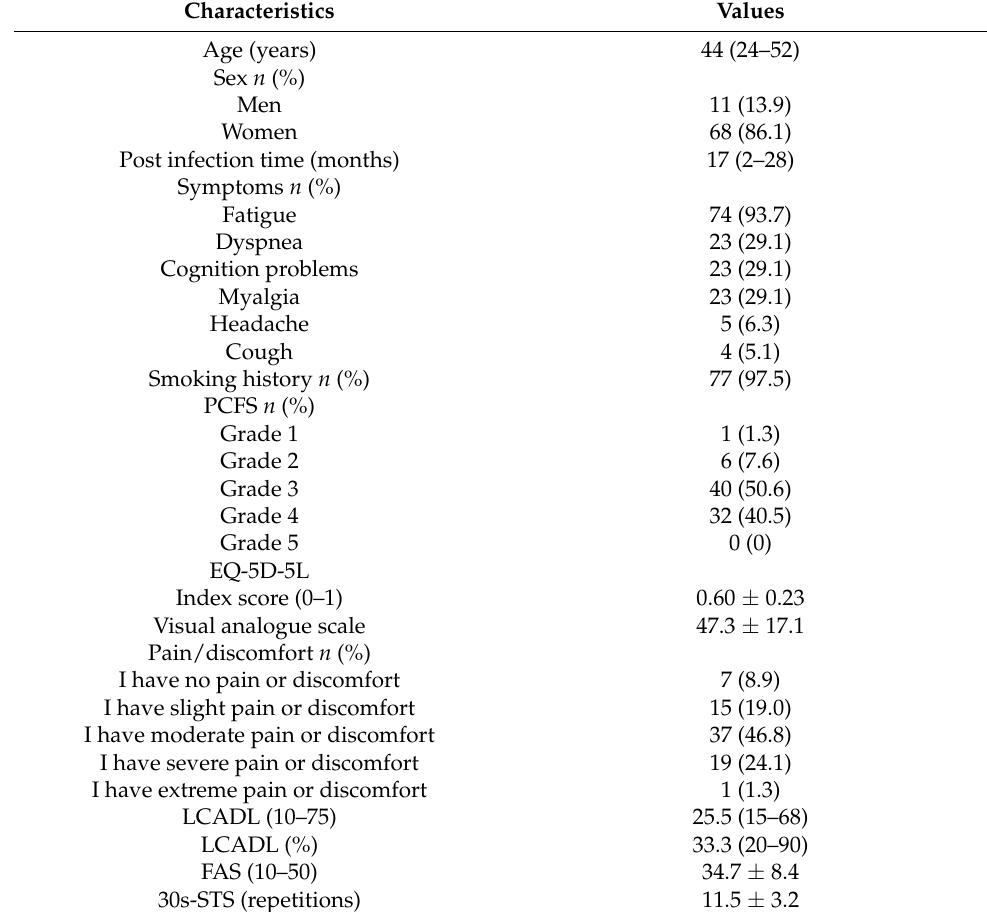
Table 1. Baseline characterization of patients ( n =